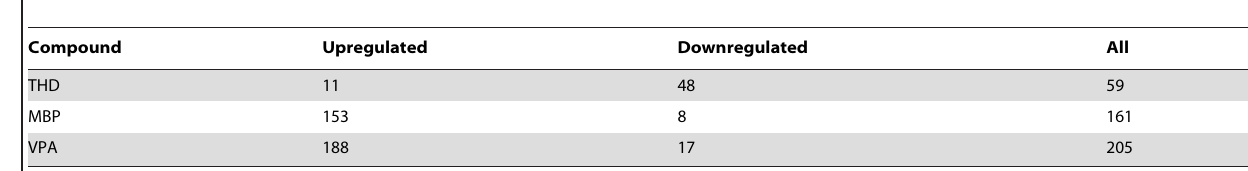
Table 5. Number of DEGs after exposure to THD, MBP or VPA for 24 h compared with their time-matched controls.